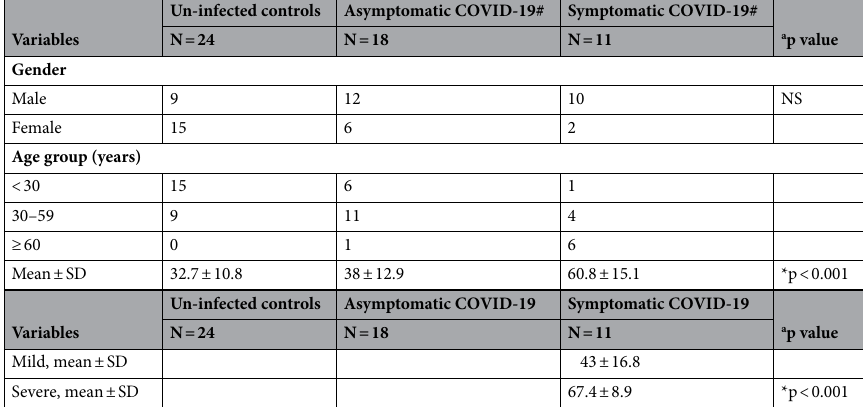
comorbid conditions such as, diabetes, cardiac or kidney disease; male gender and advanced age are associated with poor disease outcomes 13 . SARS-CoV-2 attaches via its spike protein to host cells by binding to the angiotensin-converting enzyme 2 (ACE2) receptor 14 . Acute inflammation results from SARS-CoV-2 infection of pneumocytes, causing a cytopathic effect as it spreads 15 . A ‘cytokine storm’ induced via pathways such as, inflammasome activation and modulation of host innate immune cells leads to unfavorable COVID-19 outcomes 16 . T helper and T regulatory cells are shown to be dysregulated by SARS-CoV-2 infection, affecting adaptive immunity 17 . SARS-CoV-2 also triggers IL-4 and IL-10 which are Th2 cytokines, possible regulators of inflammatory responses, but IL-10 counteracts antiviral T cell responses 18 . Effective anti-viral responses require a combination of innate and adaptive immune responses. Innate responses driven by Natural Killer cells, monocytes and B cells are regulated by T cells, cytokines and chemokines which, recruit leucocyte sub-sets to the site of infection. Type I interferon (IFN) responses drive interferon- stimulated genes (ISGs) for timely resolution of infection, such as in protection against SARS-CoV-2 infection 19 . However, whilst SARS-CoV, Middle-East Respiratory Syndrome (MERS) virus and respiratory syncytial virus infections have all been shown to induce type I and type III interferon signaling pathways, SARS-CoV-2 may bypass the induction of type I and III interferon responses to replicate in host cells 20 . Despite the importance of type I interferons in viral clearance, there is still ambiguity regarding its role in COVID-19 19 . Compromised activation of type I IFN responses in SARS-CoV-2 patients are associated with disease severity. However, other studies have shown increased IFN activation to be associated with exacerbated COVID-19 21 . Here we used an RNA microarray based blood transcriptome approach to study early host biomarkers asso- ciated with COVID-19. We focused our studies on a SARS-CoV-2 positive Asymptomatic (or with minimal symptoms) compared to Symptomatic individuals (with mild to severe) disease. We compared transcriptomes from COVID-19 cases with healthy uninfected controls. Our study provides insights into the role of interferon type I-driven responses associated with disease control in COVID-19.